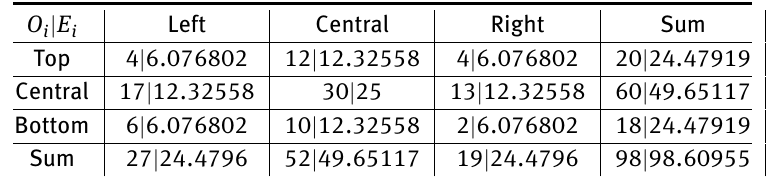
Table 1: Observed and expected data in the regions determined by the BBP in option 1 for the normal model in Example 2.1.